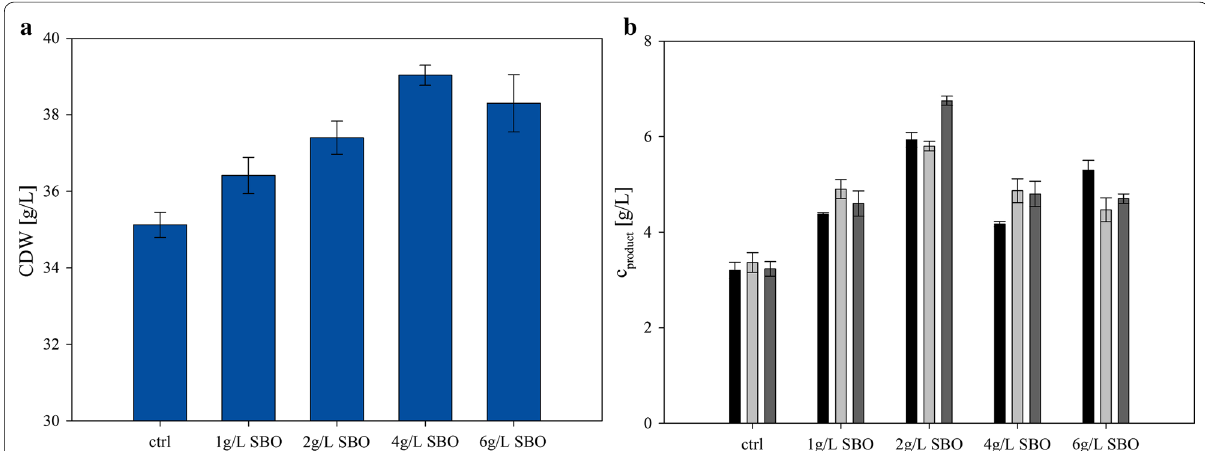
Fig. 1 Two stage shake flask experiments with P. chrysogenum and crude SBO supplemented in the preculture media. At the transfer from preculture to main culture, 3 shake flasks were inoculated from one preculture medium in order to check reproducibility. Plot a shows the CDW after 55 h of preculture at the time point of transfer with respect to different amounts of added SBO and a control run without supplementation (ctrl). Plot b shows the corresponding product concentration at the end of the main culture